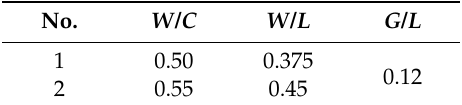
Table 7. Mixing ratios of cement paste and SRM for